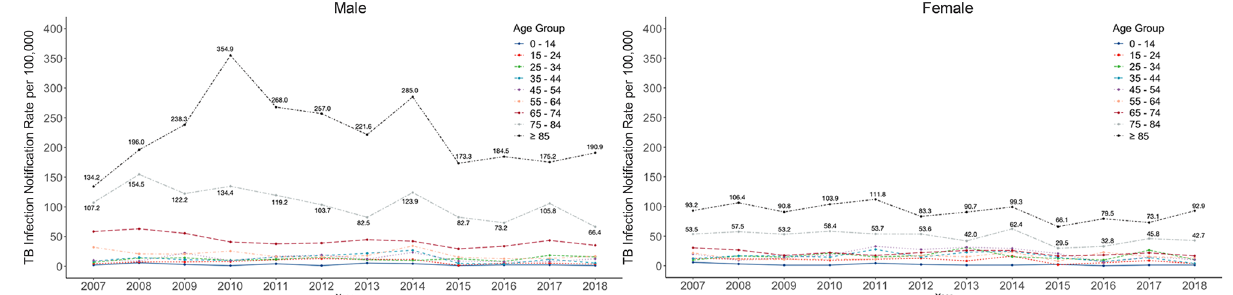
Figure 3. Male/female notification rate in different age groups of TB infections in Nagasaki Prefecture, 2007 to 2018.